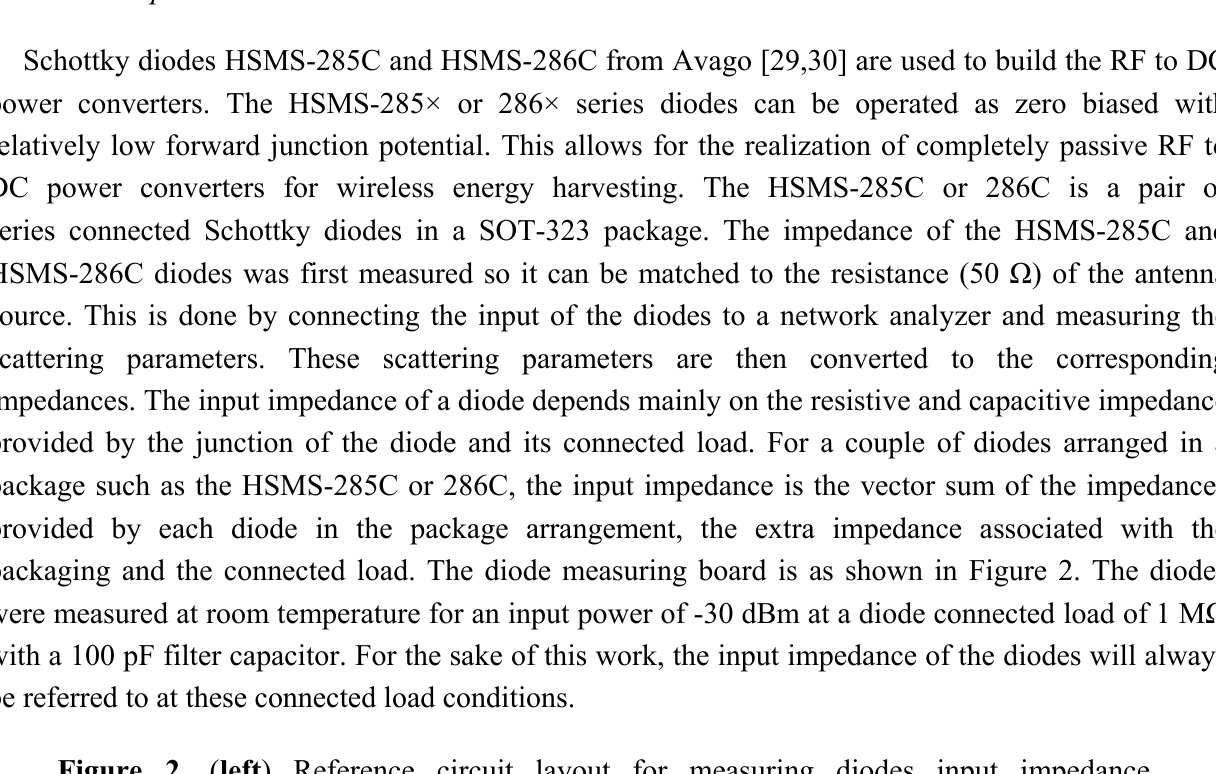
Figure 2. ( left ) Reference circuit layout for measuring diodes input impedance, ( right ) measuring printed circuit board (PCB) for diodes input impedance on 1 mm FR4 substrate.